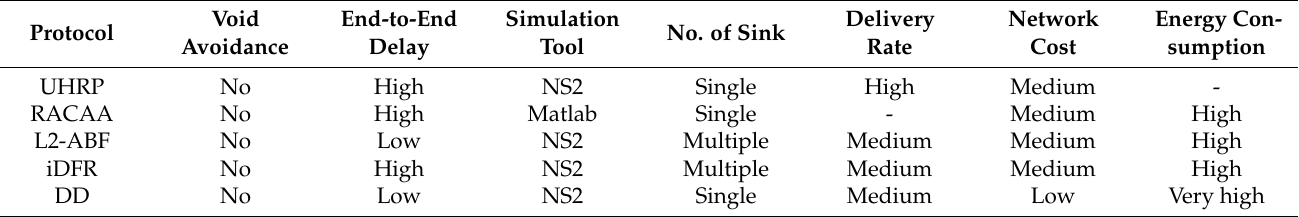
Table 18. Comparison of direction aware routing